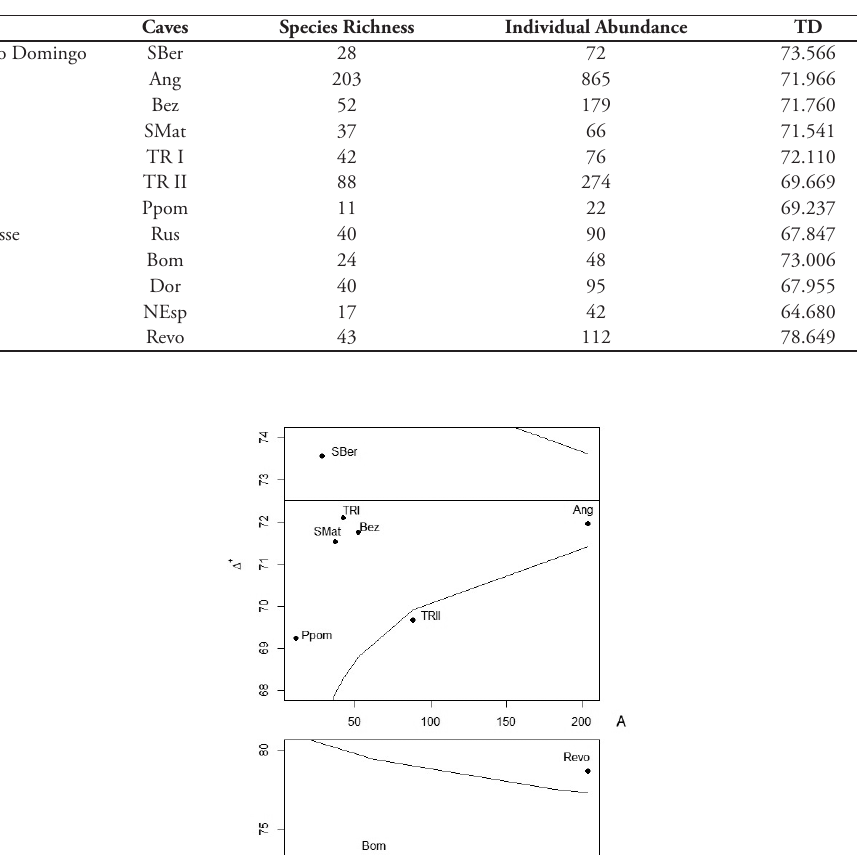
Table 1. Species richness, individual abundance, and taxonomic distinctness (TD) of caves from north- eastern Goiás karst area (São Domingos and Posse). Legend: SBer= São Bernardo cave system, Ang= Lapa Angélica, Bez= Lapa do Bezerra, SMat= São Mateus cave system, TR_I= Terra Ronca I cave, TR_II= Terra Ronca II cave, PPom= Pau Pombo cave, Rus= Russão cave system, Bom= Bombas cave system, Dor= Doralino cave system, NEsp= Nova Esperança cave, Rev= Revolucionários cave.